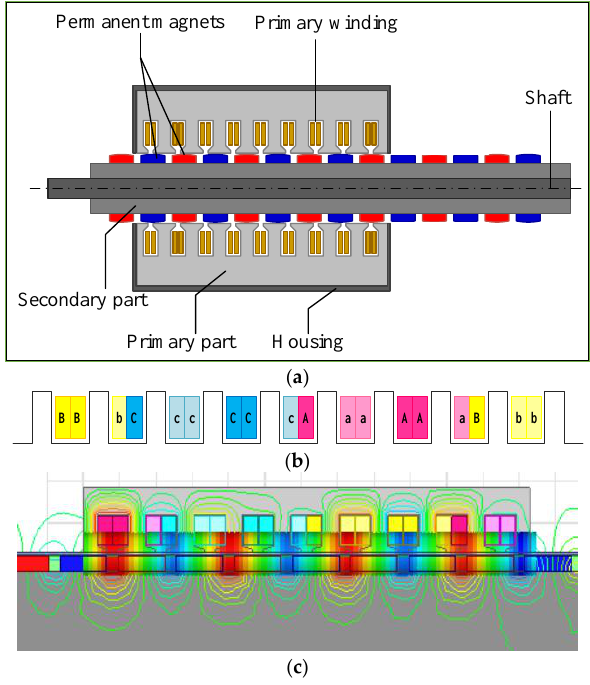
Figure 2. The electromagnetic model of the designed CPMLG. ( a ) Schematic diagram; ( b ) Winding distribution diagram; ( c ) Finite element meshing diagram.